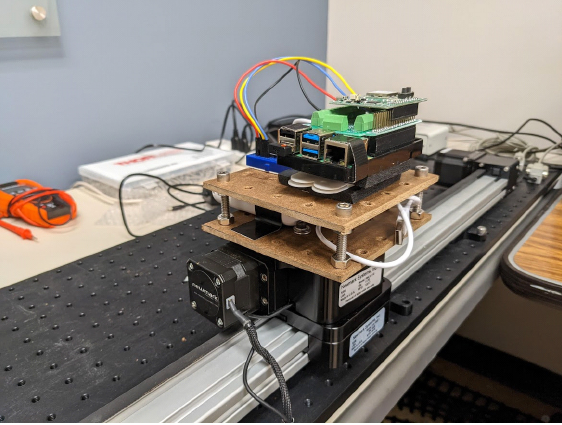
Figure 4. The UWB/IMU tracking device installed on the testing